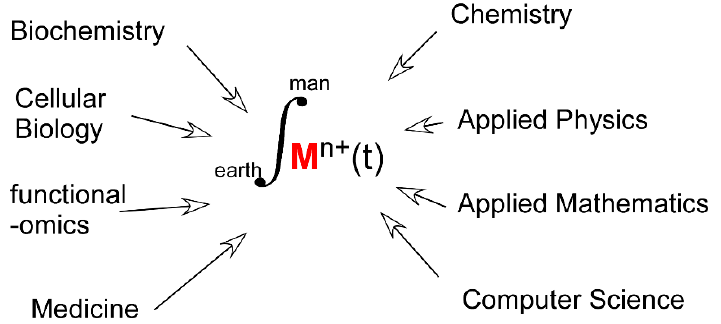
Figure 6. Transition Metals in Biology: a contemporary call for Integrative Science.